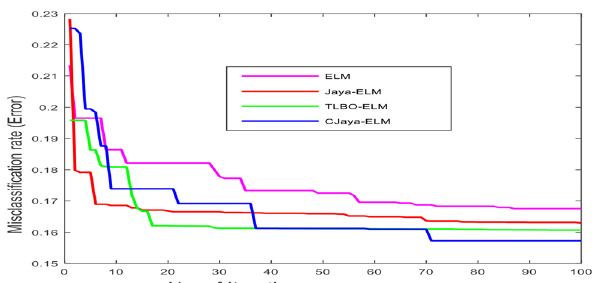
Figure 5: No. of iterations versus miss classification rate of ELM based